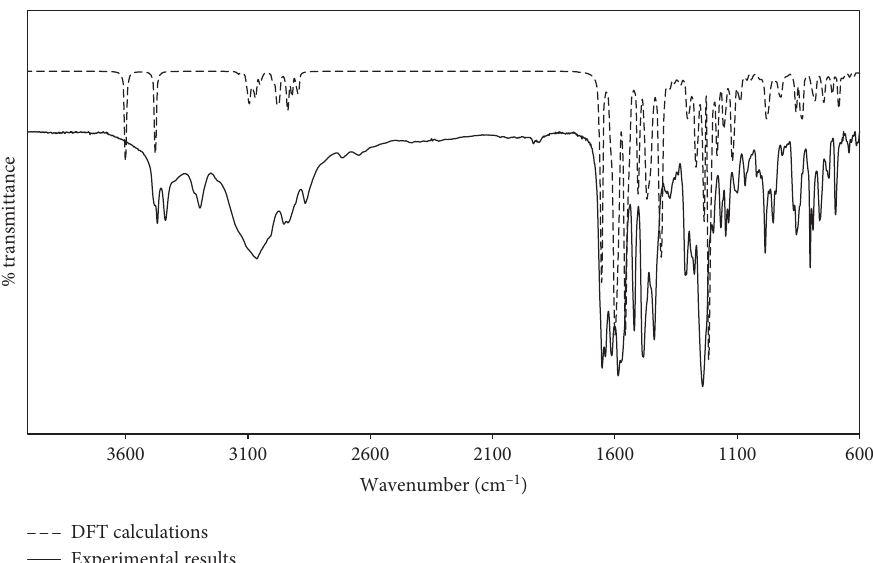
Figure 3: Fourier transform infrared spectrum of ibrutinib. The spectrum is used to determine the molecule’s structural information, especially the functional groups N-H 2 (at 3599.6, 3478.0cm − 1 ) and C � O (at 1652.4, 1639.19cm − 1 ).